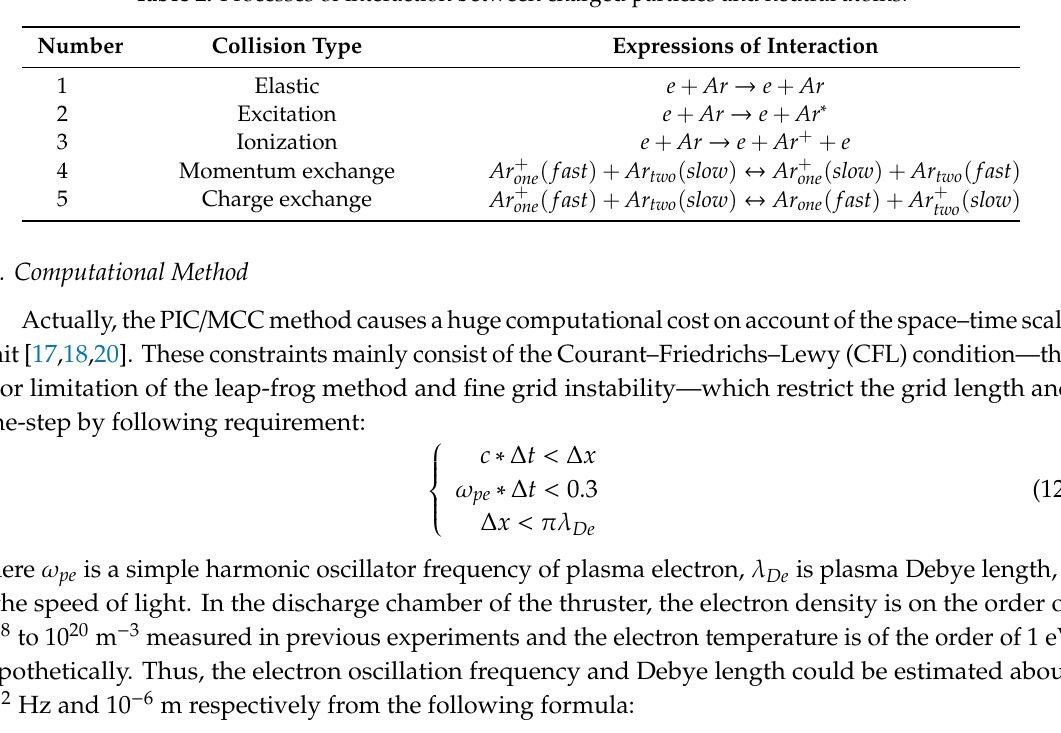
Table 2. Processes of interaction between charged particles and neutral atoms.